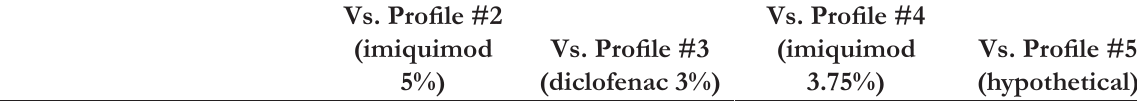
Table 4. Multivariate Tobit Regression of the Determinants of Incremental WTP for Ingenol Mebutate